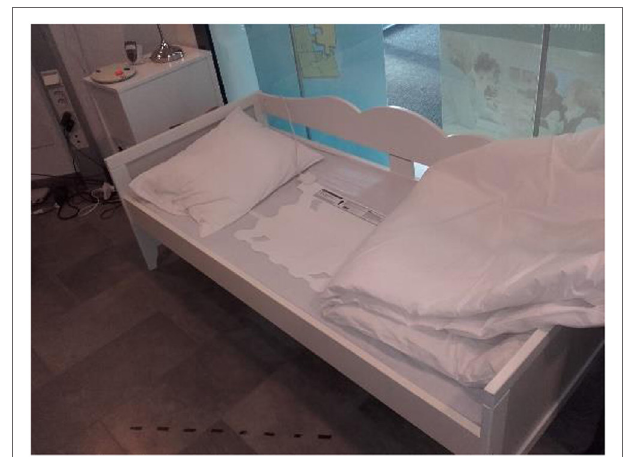
FigUre 1 | Bed equipped with a visible flat pressure sensitive sensor.